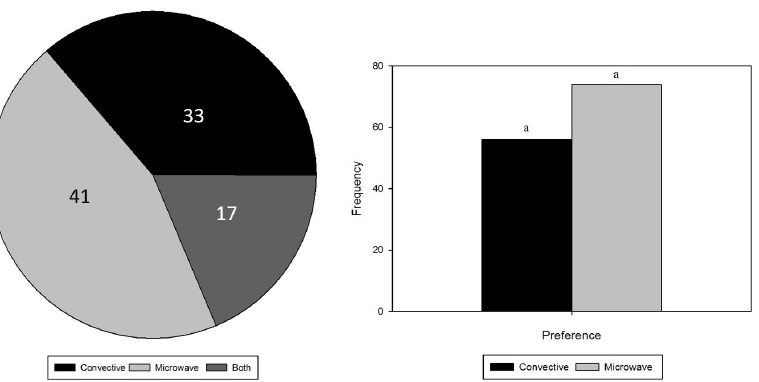
Figure 2. Willingness to buy ( left, n = 94 ) and preference ( right, n = 130 ) regarding chocolate produced from convectively and microwave roasted beans (in number of persons). Regarding willingness to buy, only 94 participants (out of 130) indicated that they were willing to buy at least one sample. No significant differences (ns) were detected for either the willingness to buy or the preference between the chocolates based on a 5% significance level.